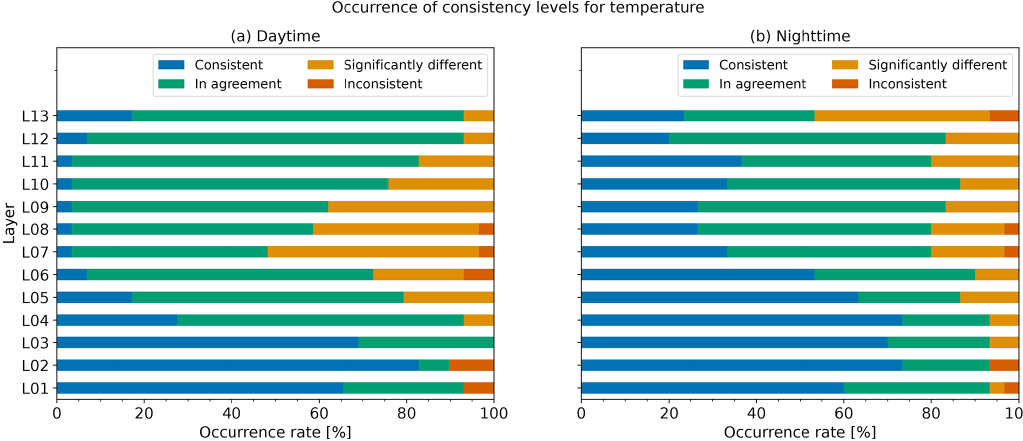
Figure 19. Temperature consistency rank for individual pressure